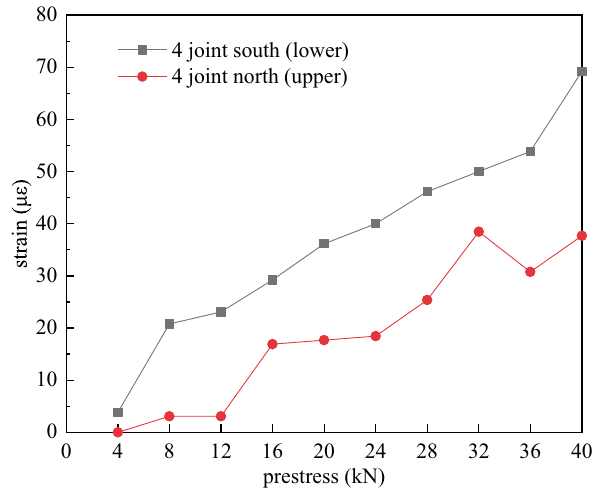
Fig. 25 Micro strain comparison